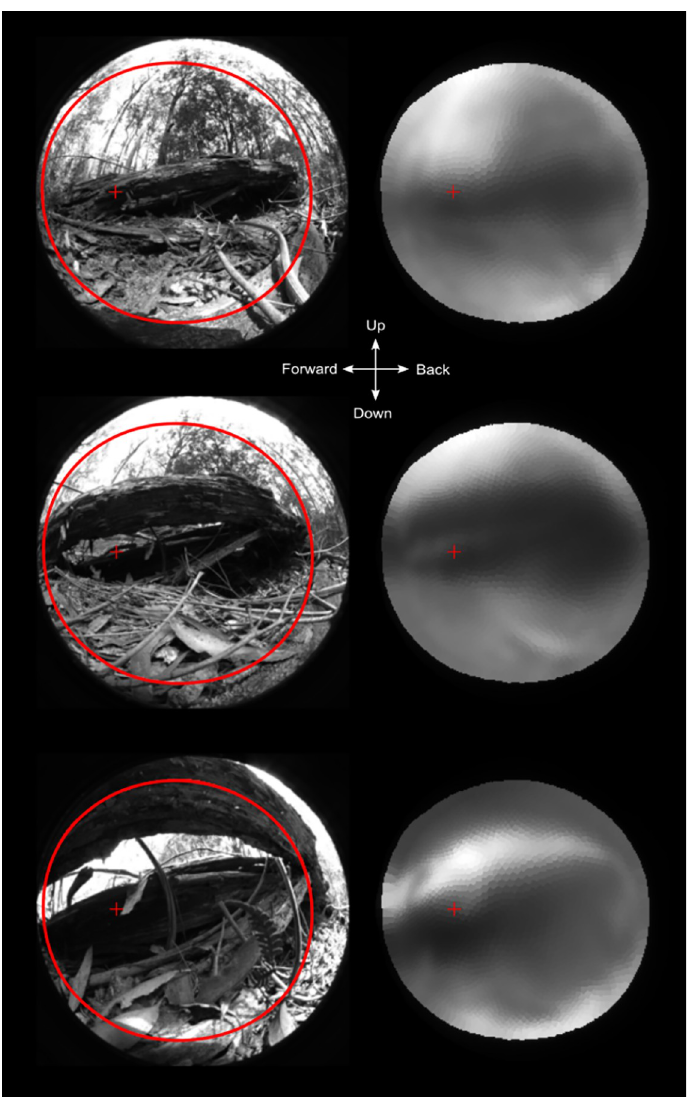
Fig 9. Velvet worm view of their natural habitat. The original images are 180˚ equisolid angle fisheye images taken from velvet worm vantage points in their natural habitat. All images contain major structures (fallen logs) under which velvet worms were found hiding during the day. Only these major structures are passed by the eye’s optics. This would be enough to navigate towards dark hiding places but not for seeing other animals. The large red circle indicates the field of view and the small cross is the centre of the area with highest resolution. The images are for the right eye of the animal and the centre cross indicates the view directions.